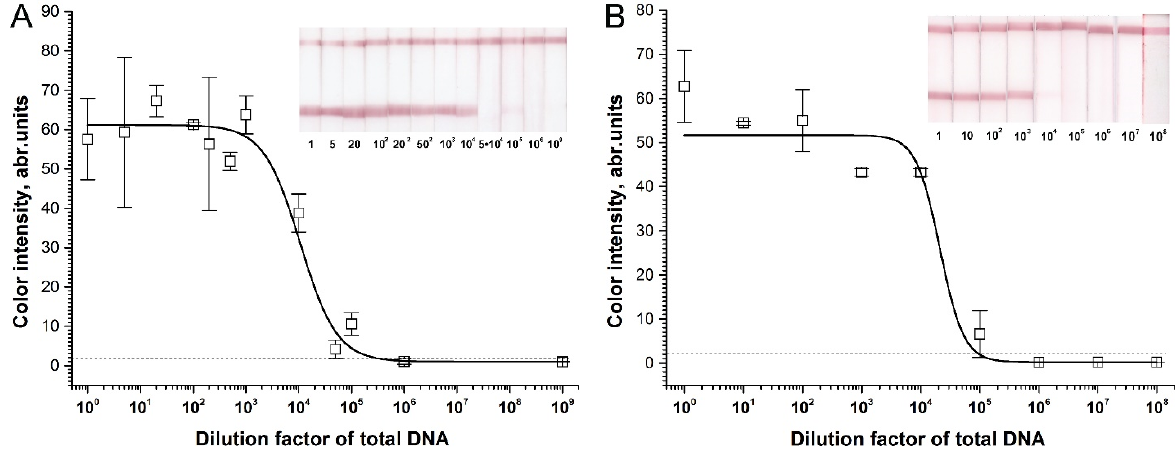
Figure 4. Dependences of color intensity in the test zone after RPA–LFA for the dilution of total DNA from chicken ( A ) and pork ( B ) meat. The scans of the strips correspond to the plotted values. The dashed line represents the signal visible to the naked eye (2 a.u.).